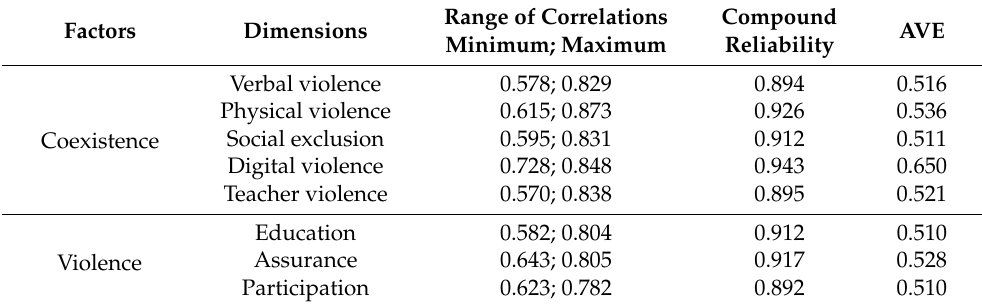
Table 8. Convergent validity indicators. Source: prepared by the authors.